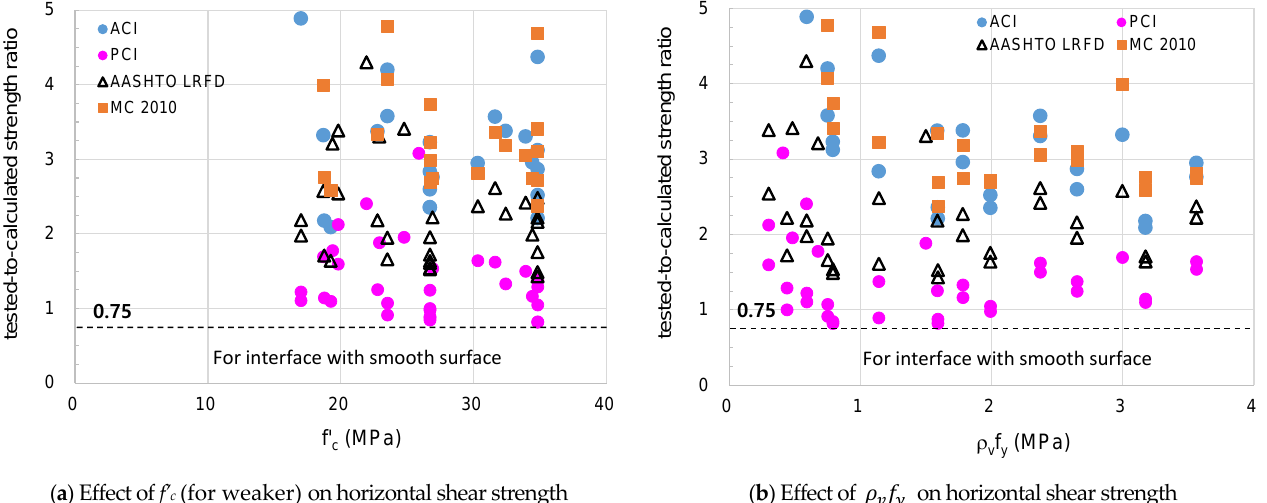
Figure 10. Tested-to-calculated shear strength ratios for beam tests with Case 2 category (roughened surface).